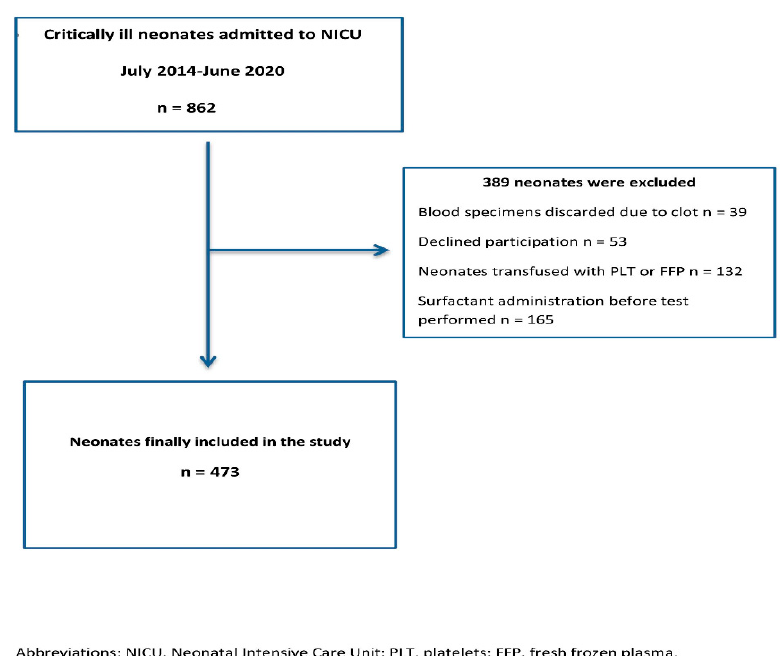
Figure 1. Flow-chart of study population.